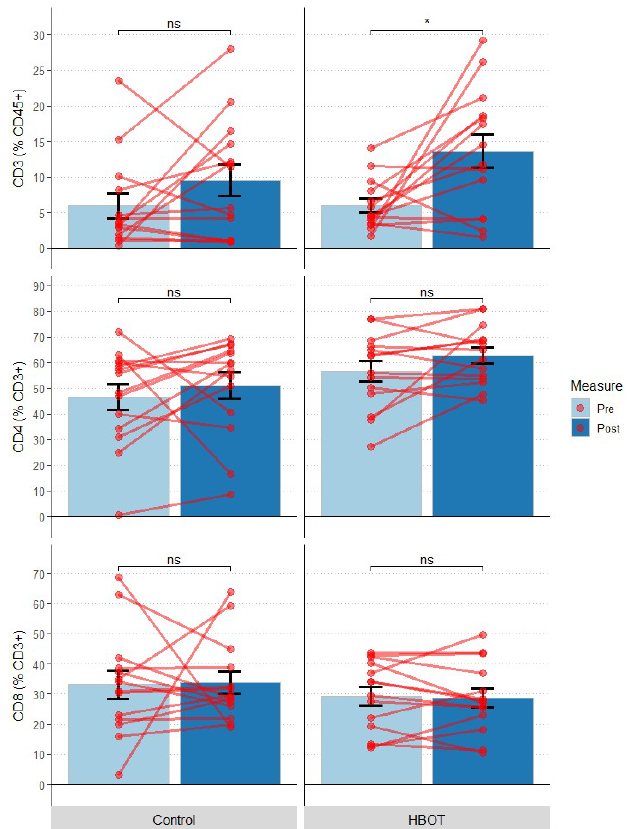
Figure 6. Change in the fraction of T-cells and their subpopulations; at first measurement (Pre) and 10 days after study onset (Post); bars represent mean, error bars represent standard error, red lines represent individual patient results; *— p < 0.05, ns— p > 0.05; HBOT n = 14, Control n = 14.